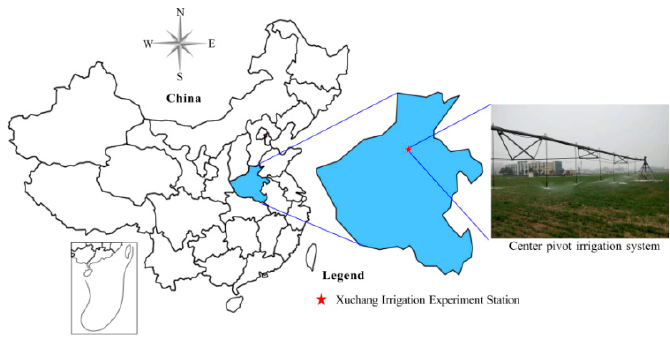
Figure 1. Schematic location of the Xuchang Irrigation Experiment Station.